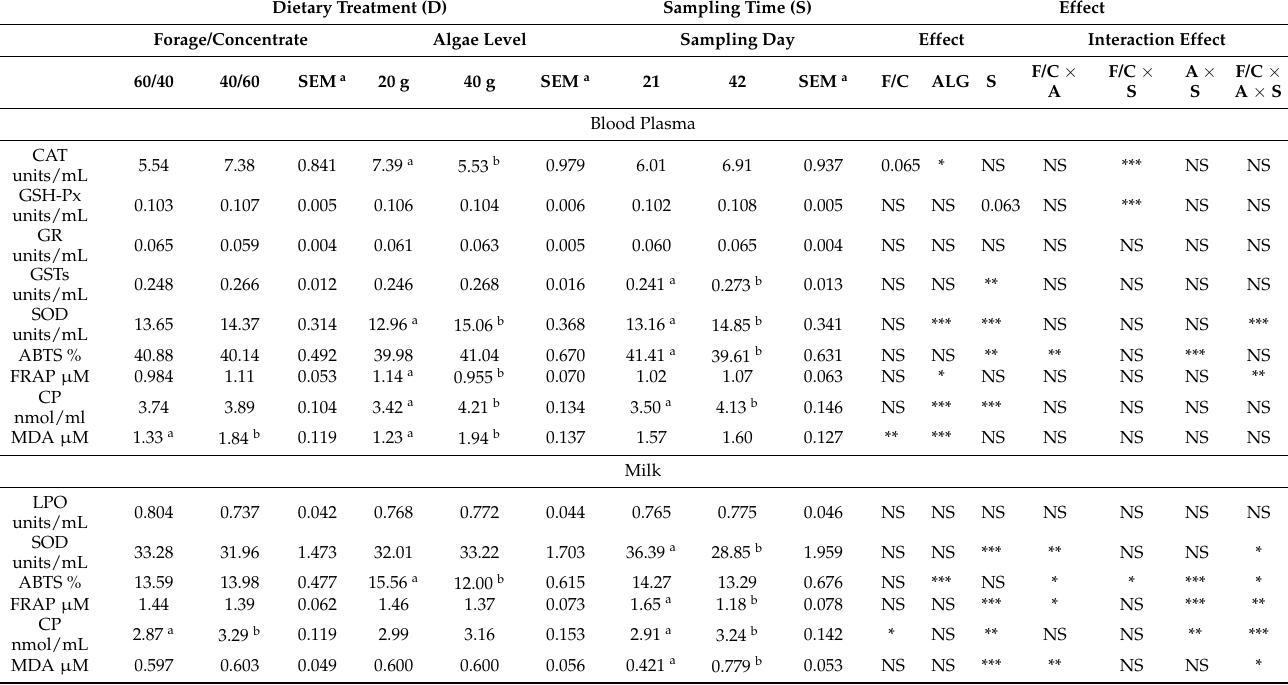
Table 6. Enzyme activities (Units/mL), total antioxidant capacity, and oxidative status biomarkers in blood plasma and milk of goats fed diets (20 HF, 20 HG, 40 HF, and 40 HG) with different levels of Schizochytrium spp. (20 g and 40 g/goat/day) and two different forage to concentrate ratios (60:40 and 40:60) throughout the experimental period (21st and 42nd experimental